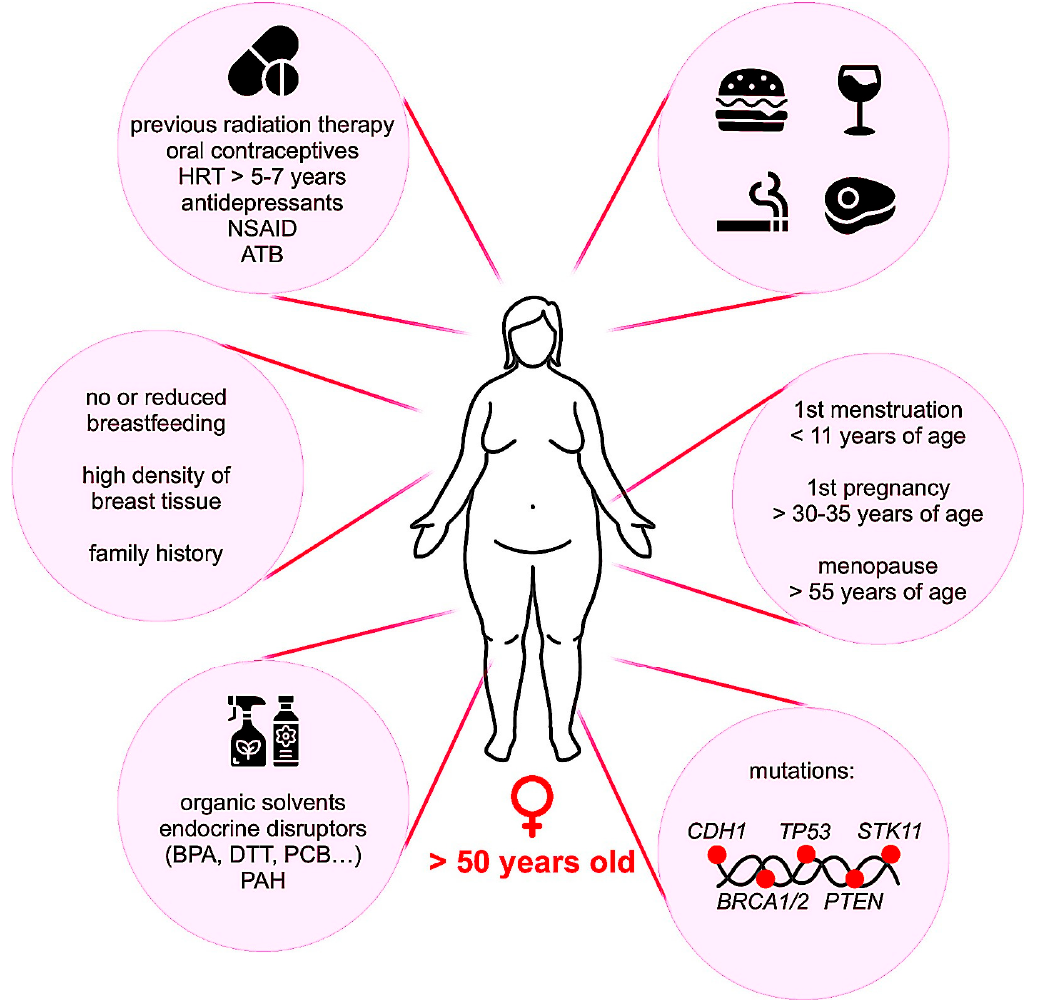
Figure 1. Risk factors of breast cancer. Genetic as well as environmental factors participate in breast cancer development. ATB: antibiotics; BPA: bisphenol A; DTT: dichlorodiphenyltrichloroethane; HRT: hormonal replacement therapy; NSAID: non-steroidal anti-inflammatory drugs; PAH: polycyclic aromatic hydrocarbons; PCB: polychlorinated biphenyls.